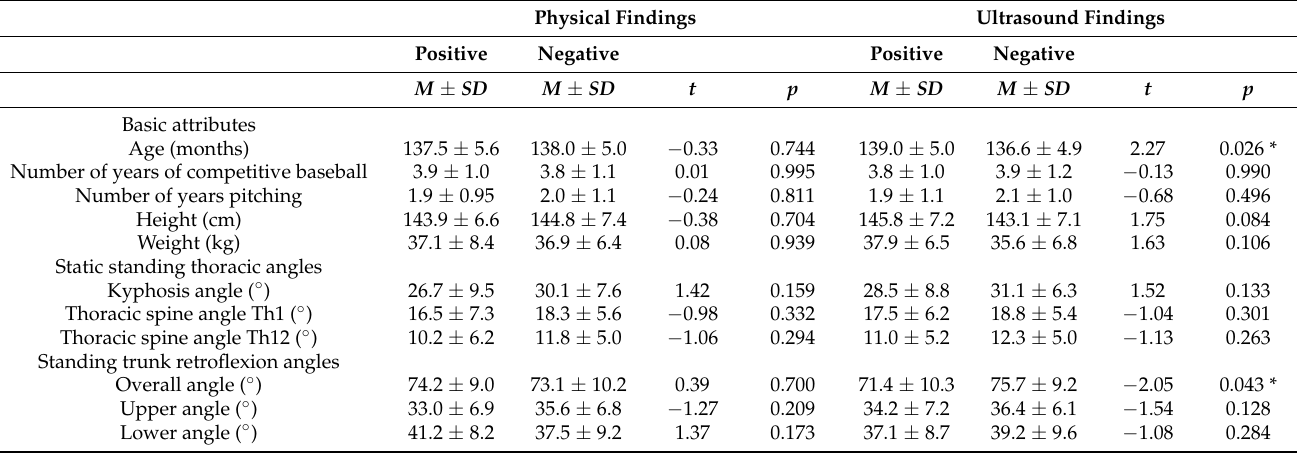
Table 4. Associations between basic attributes, thoracic spine angles, trunk angles, and medical checks. Physical